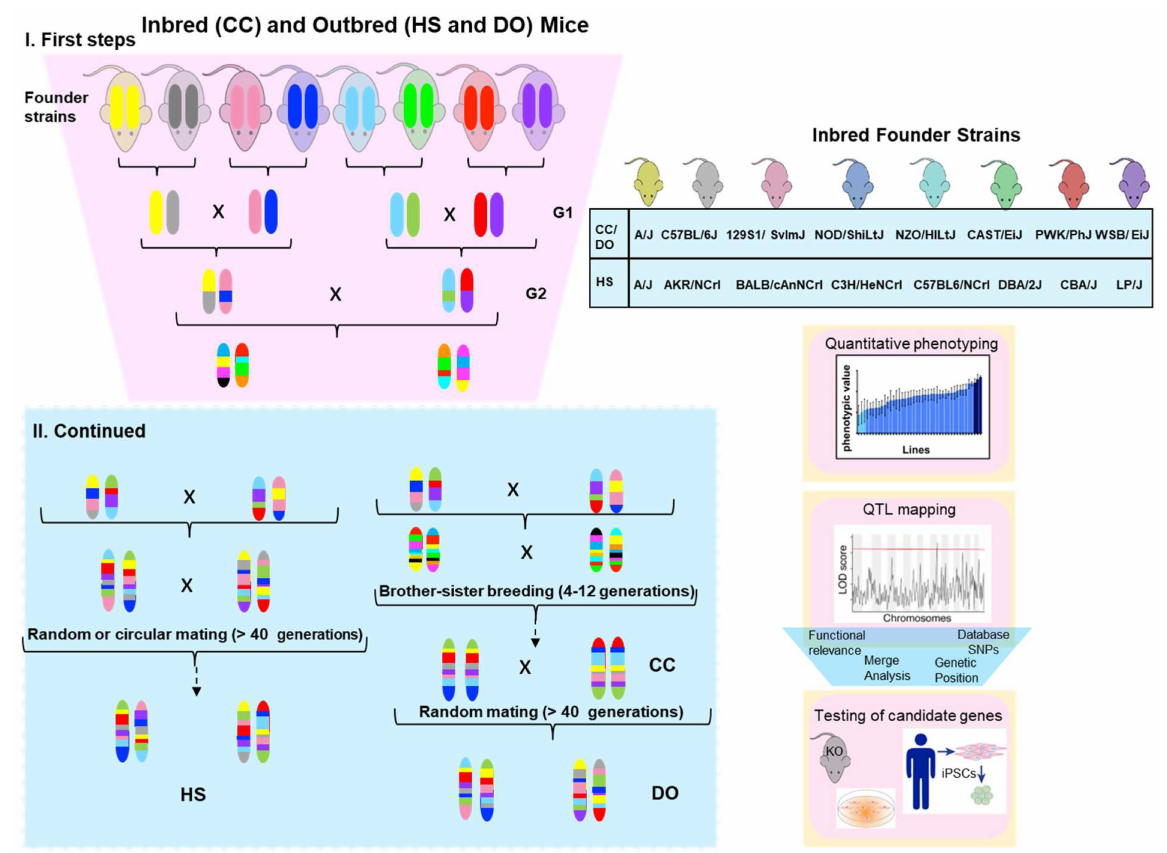
Figure 1. Breeding schemes for inbred (CC) and outbred (HS and DO) mice populations: Inbred founder strains for each panel are indicated in the right box. CC and DO populations share the same eight founder strains, five of which are standard laboratory inbred strains, while three are wild- derived strains. Colors represent the genotypes of strain chromosomes. The first steps include the combination of all eight founder genomes (outcrosses). CC is then generated as a recombinant inbred (RI) after multiple brother–sister breeding. HS and DO panels were developed as high-diversity outbred panels by over 40 generations of random outcrosses. DO was created from partially inbred Collaborative Cross (CC) mice. Quantitative phenotyping can be performed in the strains and used for gene mapping. Some signals in chromosomal locations will probably pass the threshold of significance (red line) in the LOD plot. The functional relevance of these variants can be assessed in animal models such as knockout mice and induced pluripotent stem cells (iPSC) derived from